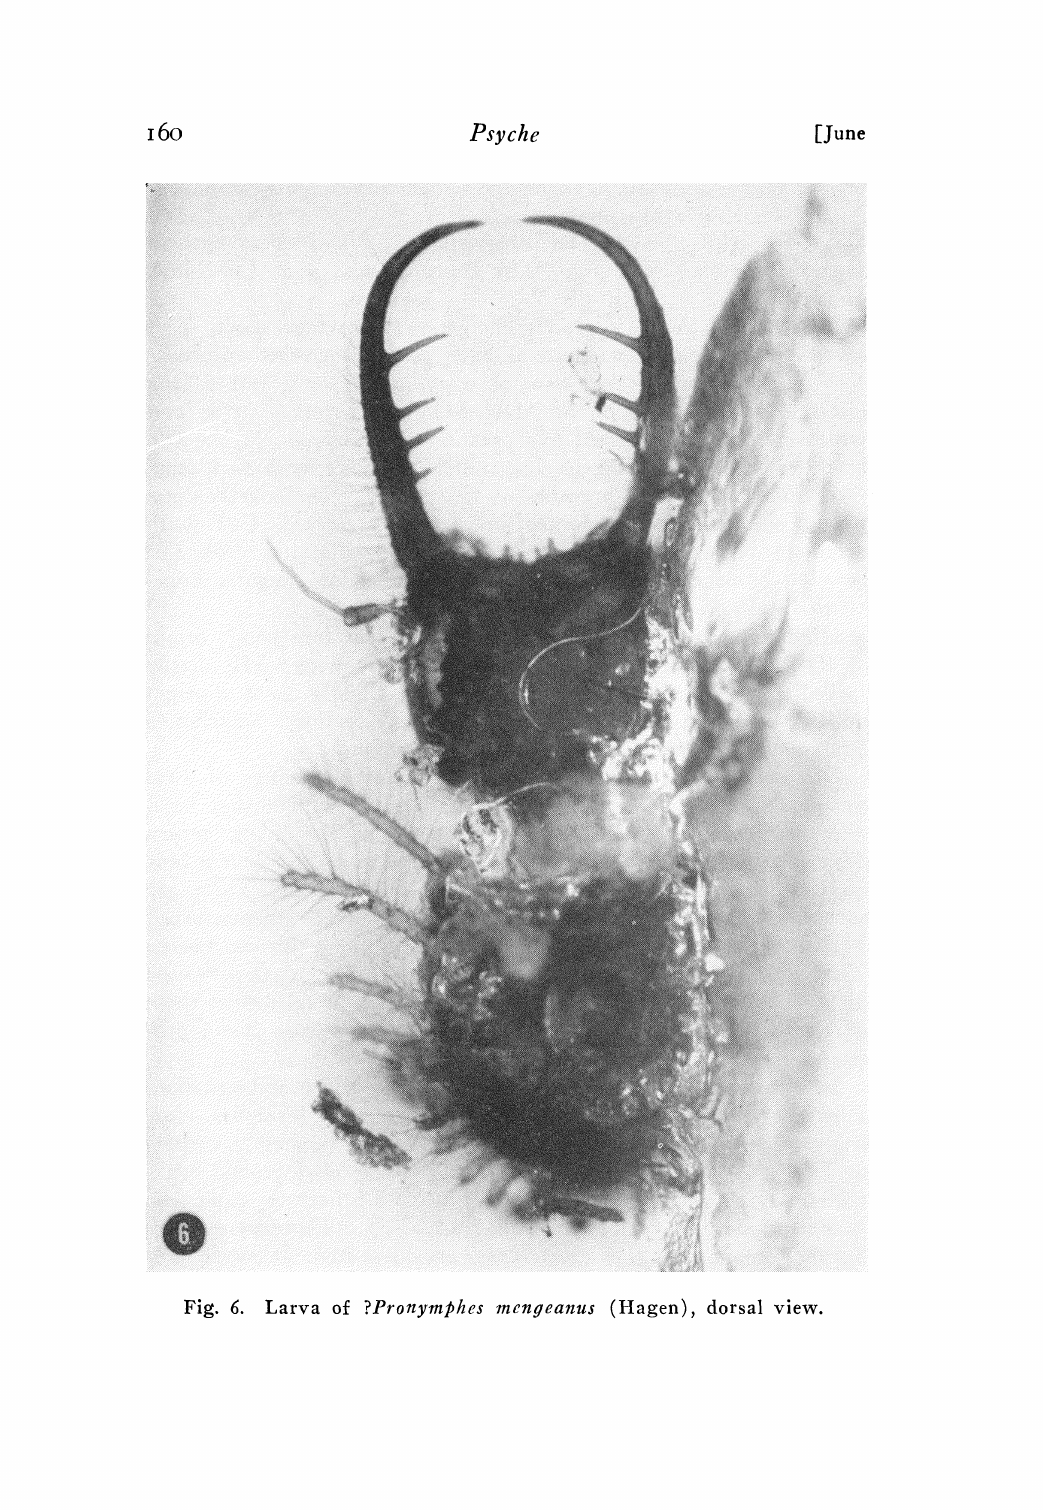
Fig. 6. Larva of ?Pronymphes mentIeanus (Hagen), dorsal